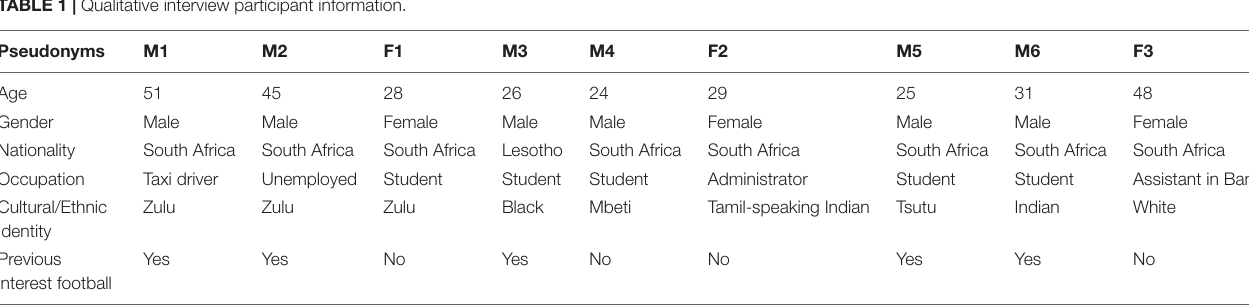
TABLE 1 | Qualitative interview participant